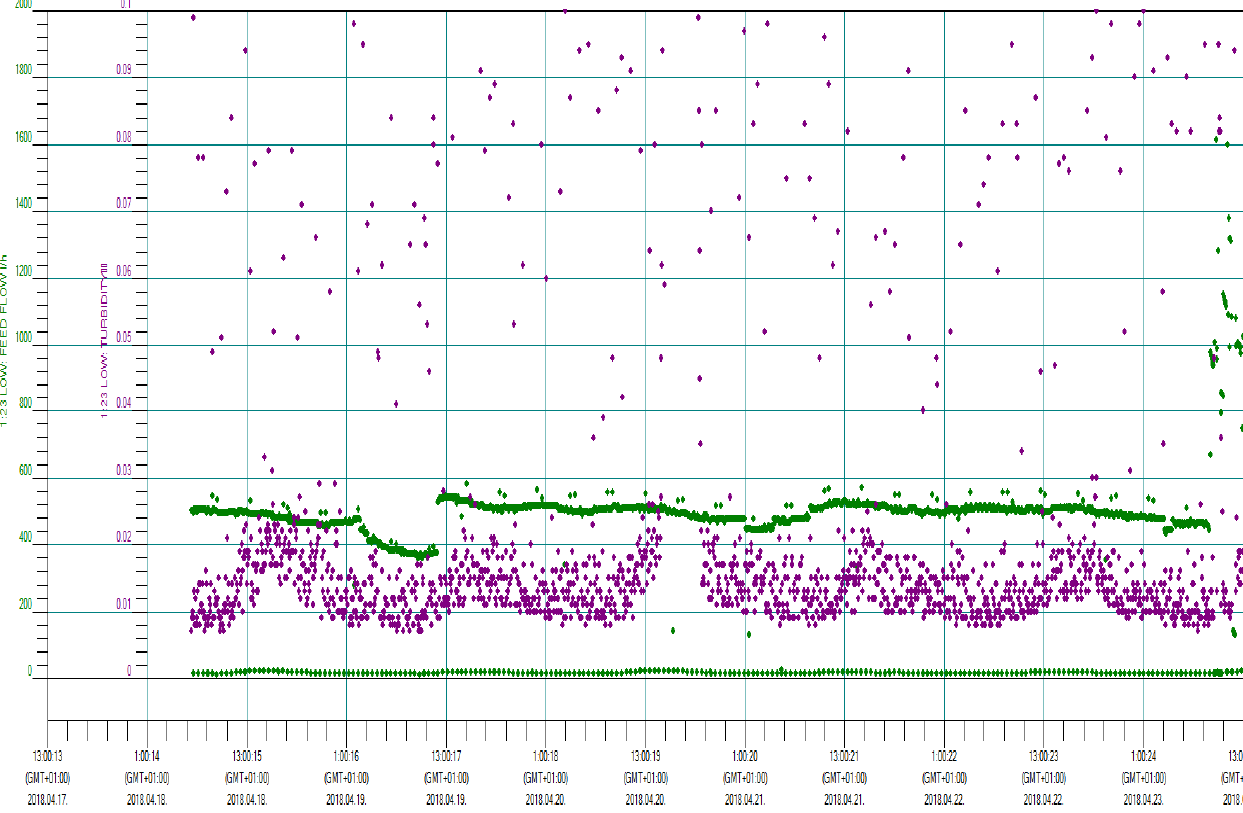
Figure A4. Flow and permeate turbidity (medium resolution).